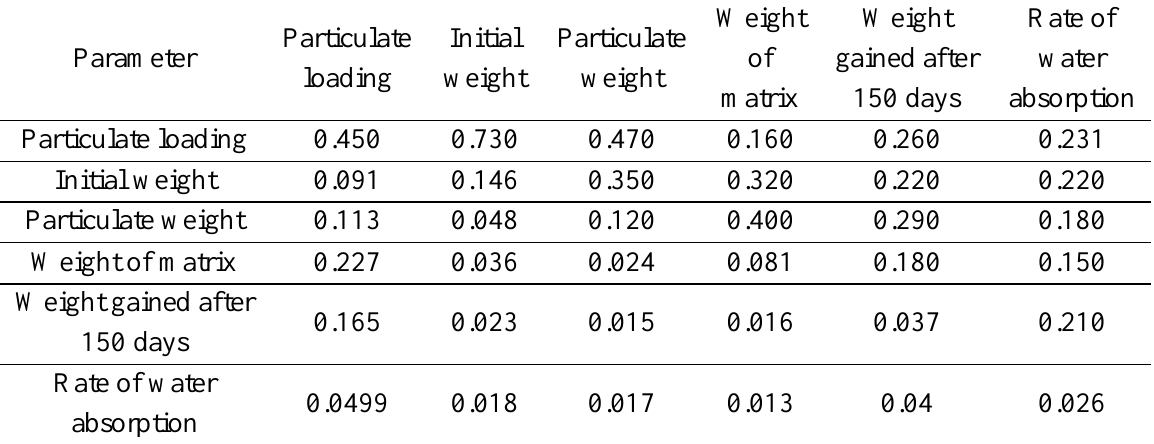
Table 10. The 6 x 6 matrix representing the values of the pairwise comparison for the cocoa pod husk